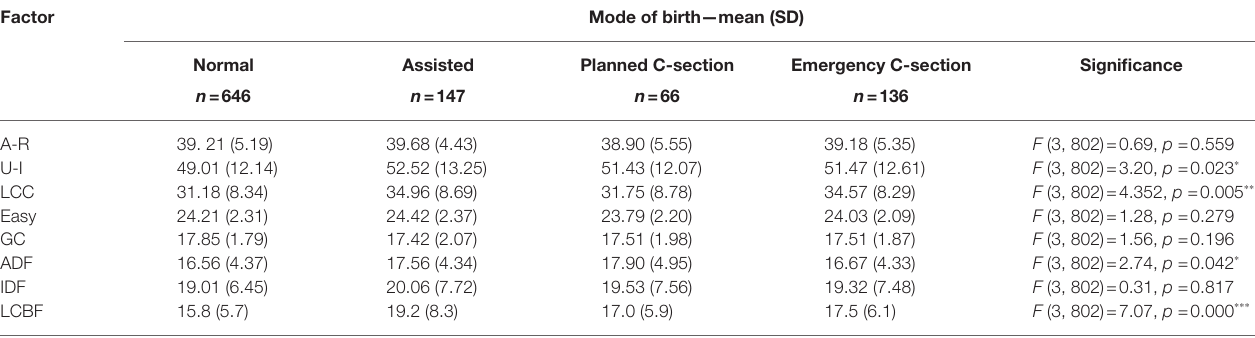
MABS items are defined in Table 1 . * Multivariate analysis of covariance F ratios: p < 0.05.